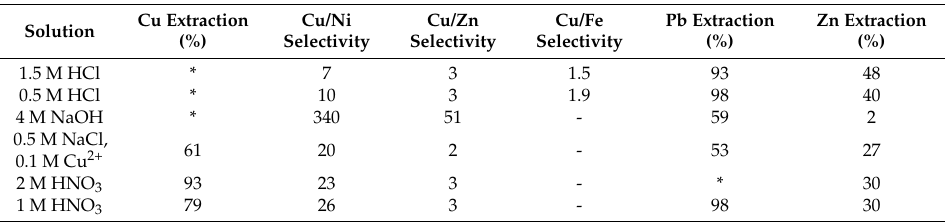
Table 5. The best lixiviants selected for Cu, Fe, Pb, and Zn